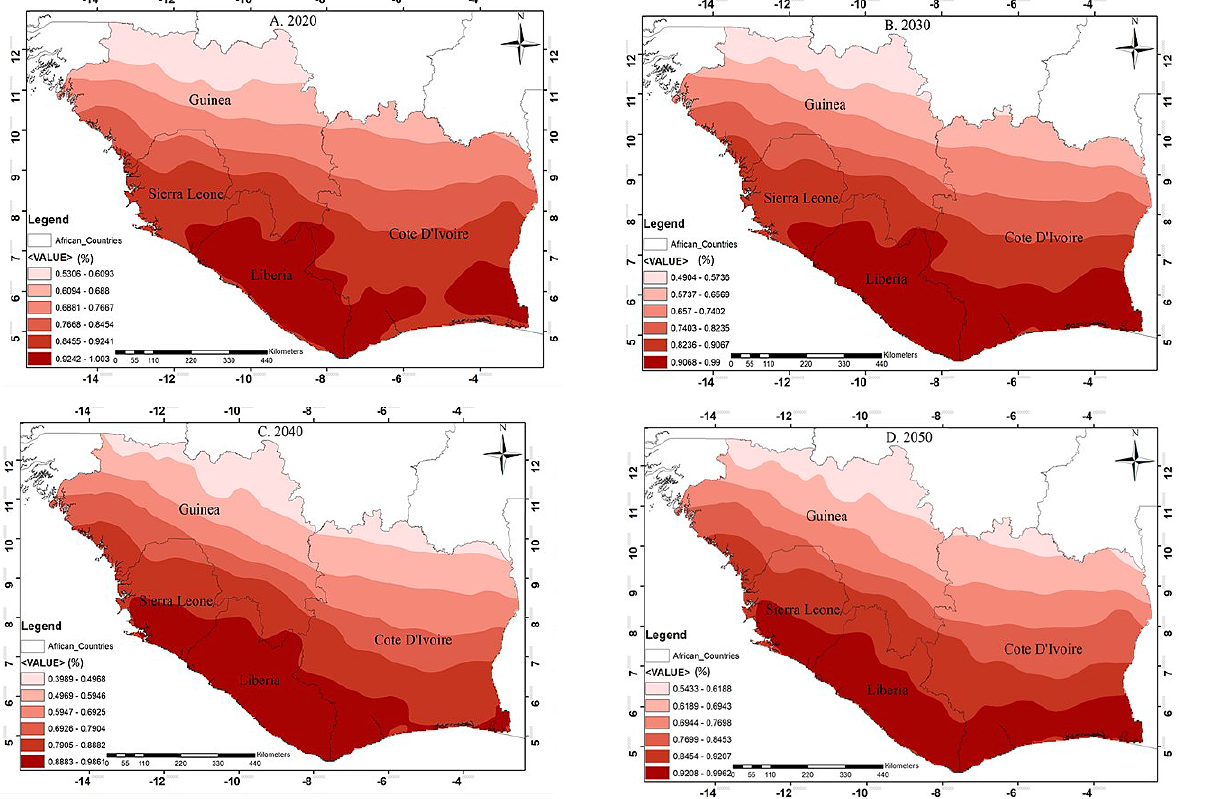
Figure 5. Decadal Spatial Distribution of Relative Humidity (%) in the MRU region for the period (2020-2050)